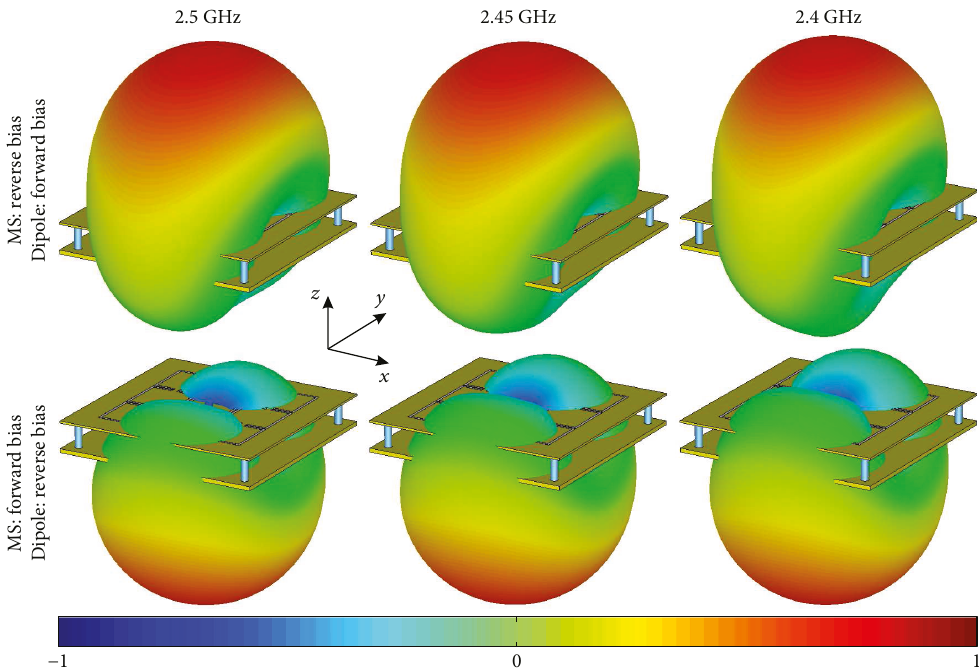
Figure 5: Simulated 3-D radiation patterns (normalized gain) of the proposed PIN diode-based recon fi gurable metasurface antenna operating in forward and reverse bias states of PIN diodes at frequencies of 2.4, 2.45, and 2.5GHz.